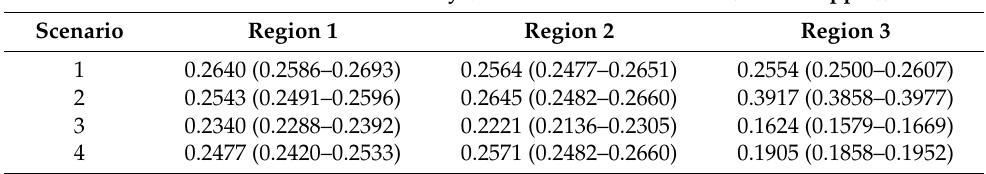
Table 4. Posterior probability of each scenario in ABC1 and its 95% hyper probability density (HPD) based on the logistic estimate by DIYABC v2.0 [42,43]. The scenarios tested in ABC1 are shown in Figure 4.